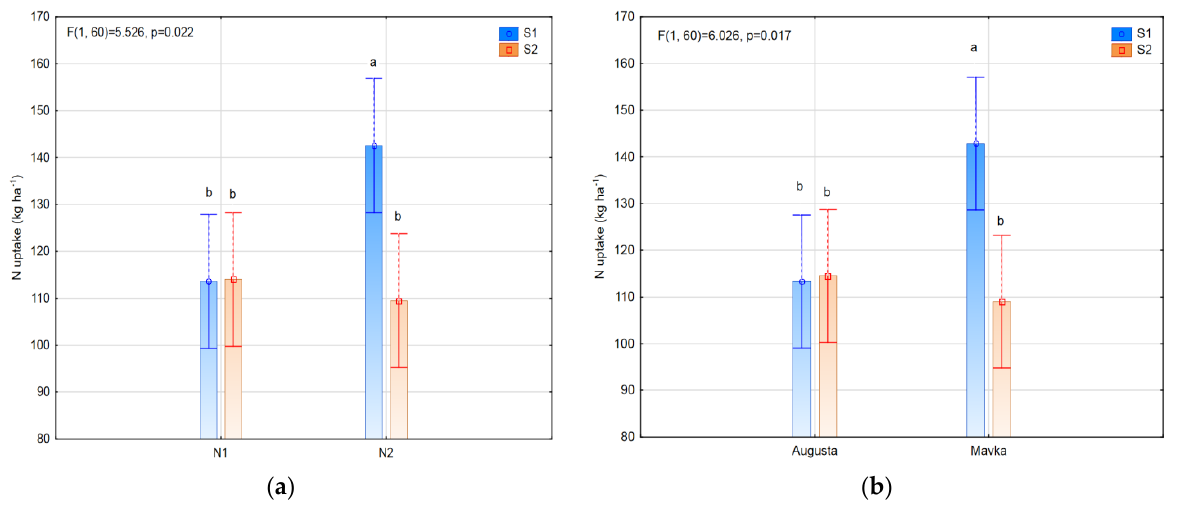
Figure 6. Significant effect of interaction of fertilizer and sowing date ( a ) and cultivar and sowing date on efficiency of N uptake ( b ). The standard error (SD) of each mean is presented as an error bar. The occurrence of the same letter pointer at averages (at least one) means that there is no statistically significant difference between them.